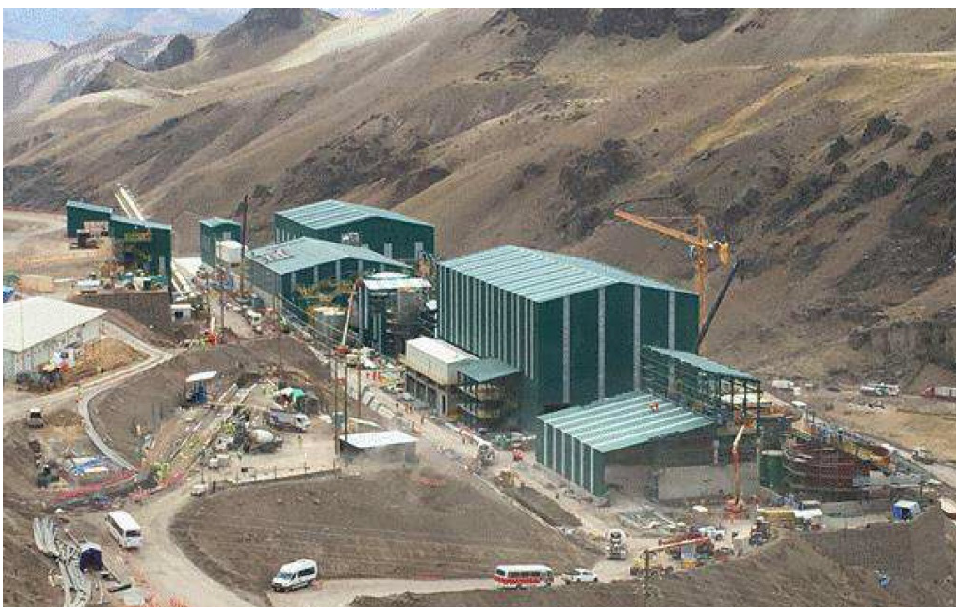
Figure 71. Tambomayo Concentrator Plant [42,43].